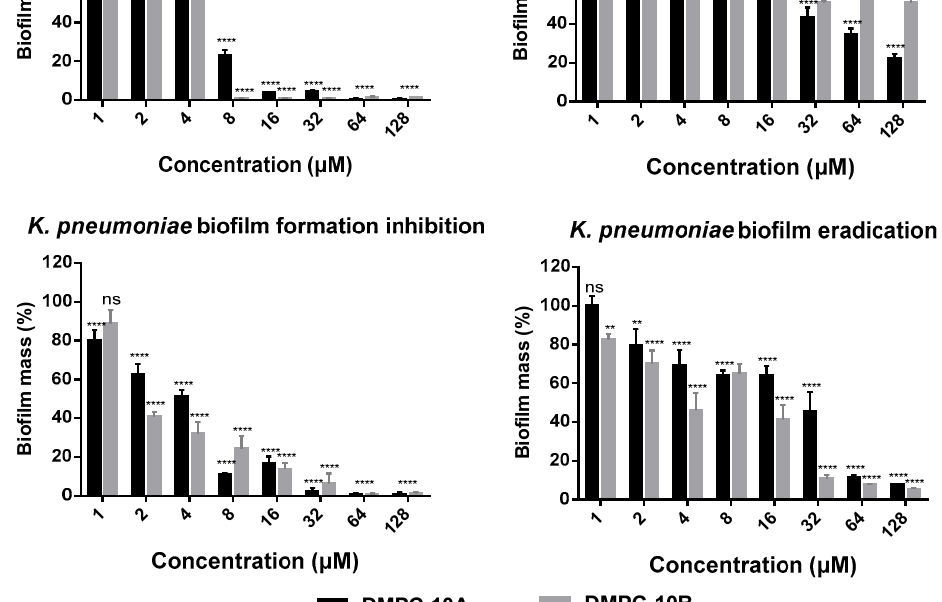
Figure 6. The percentage of biofilm mass of S. aureus (NCTC 10788), MRSA (NCTC 12493), and K. pneumoniae (ATCC 43816) after treatment with DMPC-10A and DMPC-10B in the biofilm inhibition and eradication assays. The error bar represents the standard deviation (SD) of 15 replicates in three tests (5 replicates each time). The statistical analysis was performed by one-way ANOVA and the statistical significance between the peptide concentrations and the negative control (medium treatment) is indicated as ns (nonsignificant difference), * ( p < 0.05), ** ( p < 0.01), *** ( p < 0.001) and **** ( p < 0.0001).